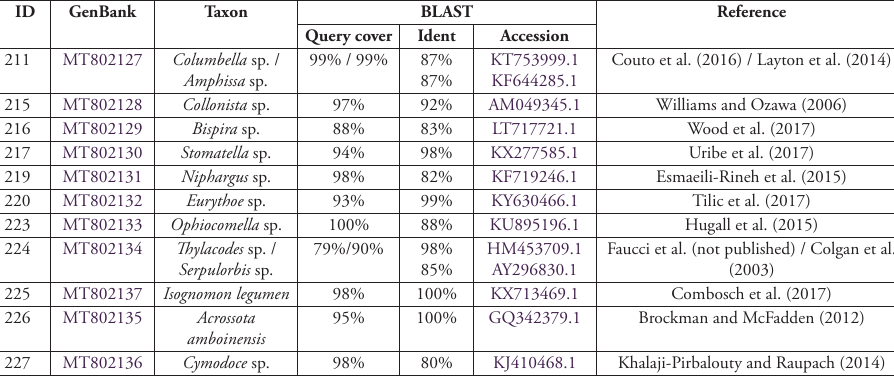
table 1. Identification of “hitchhikers” using DNA analysis; ID of the sample; GenBank: accession number; Taxon: name of the identified genus or species; BLAST: used Basic Local Alignment Search Tool and